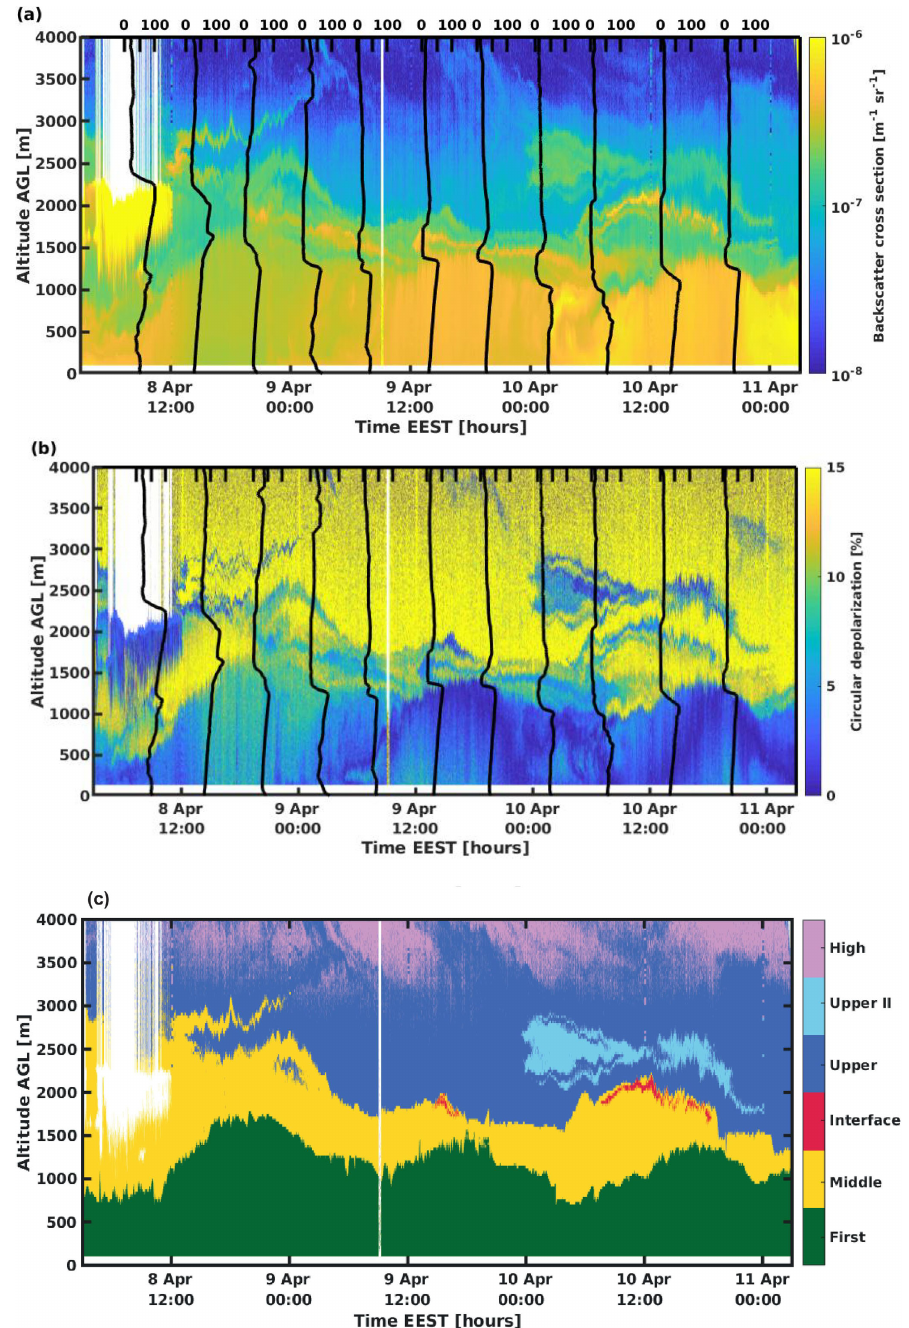
Figure 1. Case I: (a) HSRL backscatter coefficient and (b) HSRL circular depolarisation over Hyytiälä, Finland during 8–10 April 2014, with 6-hourly radiosonde relative humidity profiles superimposed in black. Larger values of the backscatter cross section indicate higher aerosol number concentration or larger particles; larger depolarisation values suggest less spherical particles. (c) Layers diagnosed from gradients in backscatter or depolarisation, with the first layer (green) comprising both boundary layer and residual layer. White pixels indicate no valid measurement due to the presence of cloud and subsequent attenuation (before midday on 12 April) or due to the calibration period (around 10EEST on 9